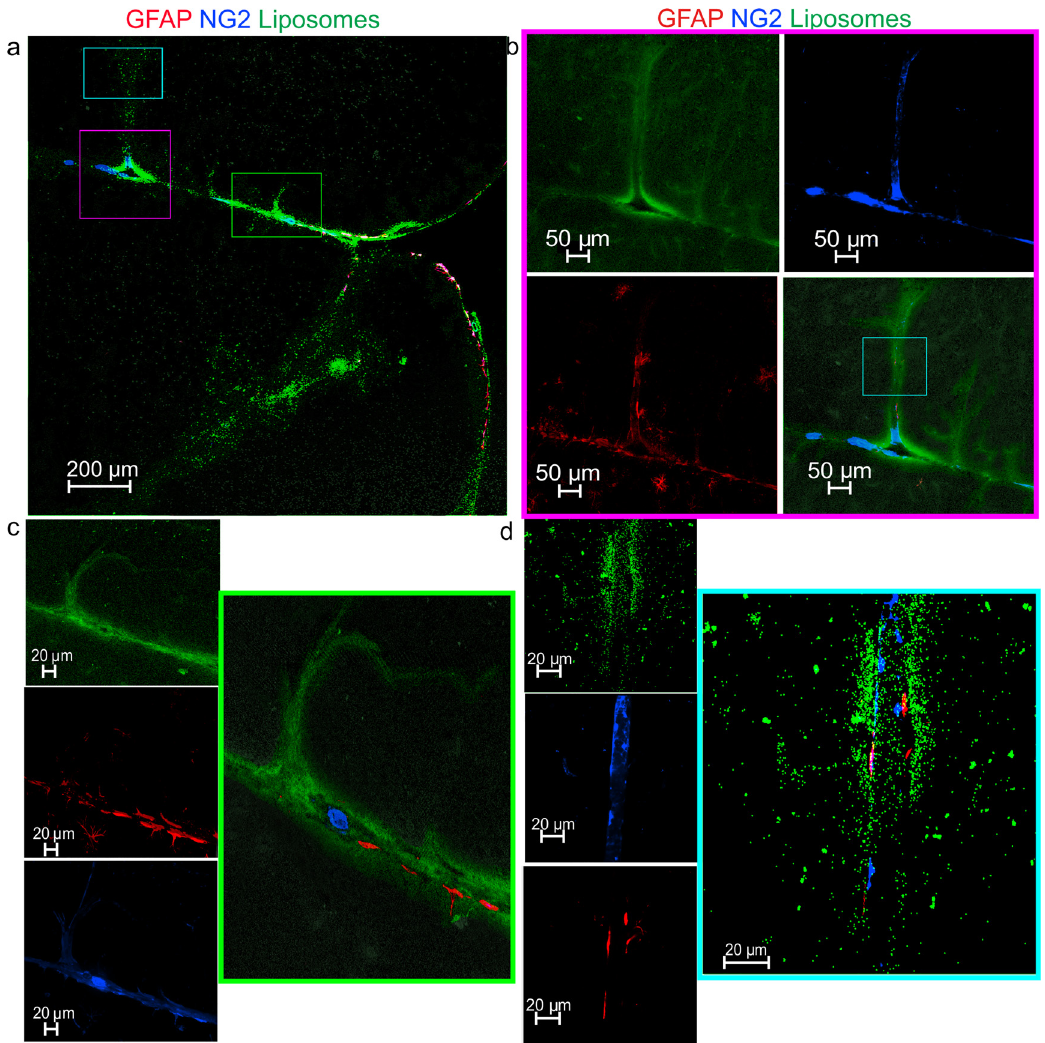
Figure 2: The lymphatic delivery of liposomes to the brain: a – Representative images of the brain tissues labeled with GFAP (astrocytic marker) and NG2 (a marker for the pericytes in the blood vessel): b – d – Representative images of the three regions of interest demonstrating the distribution of liposomes in the brain